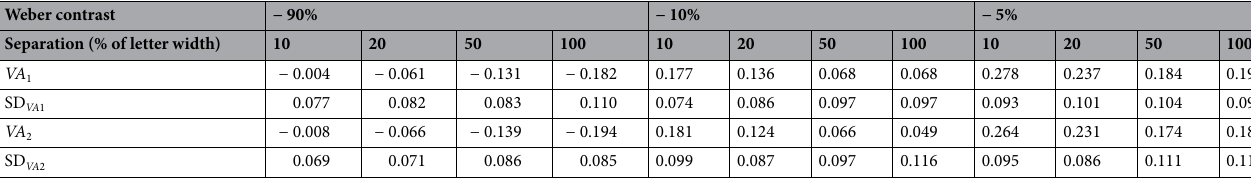
Table 1. Mean logMAR for the first, VA 1 and second, VA 2 measurements of visual acuity and their standard deviations SD VA 1 , SD VA 2 respectively, under all contrasts and letter separations